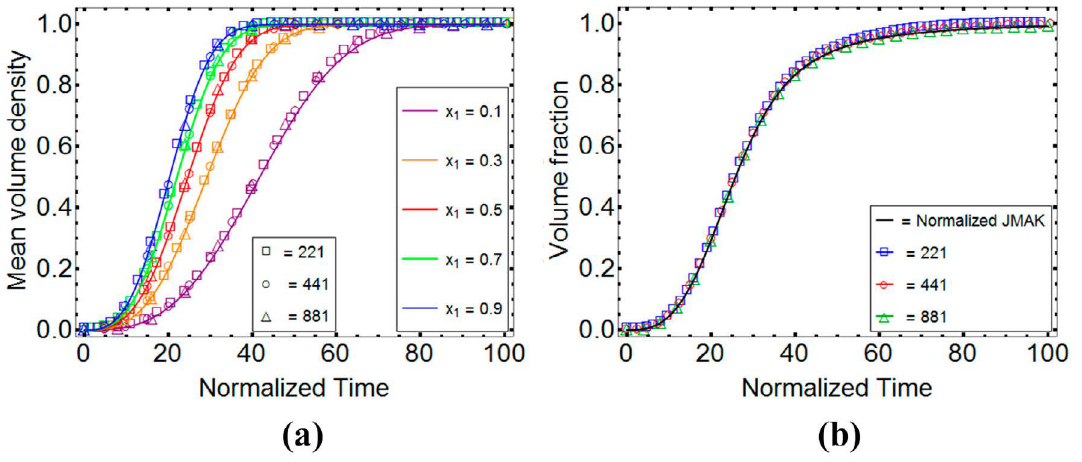
Figure 4. Transformation kinetics for oblate ellipsoids with aspect ratios: 2:2:1, 4:4:1, 8:8:1. (a) Mean volume density as a function of normalized time; (b) Volume fraction as a function of normalized time.